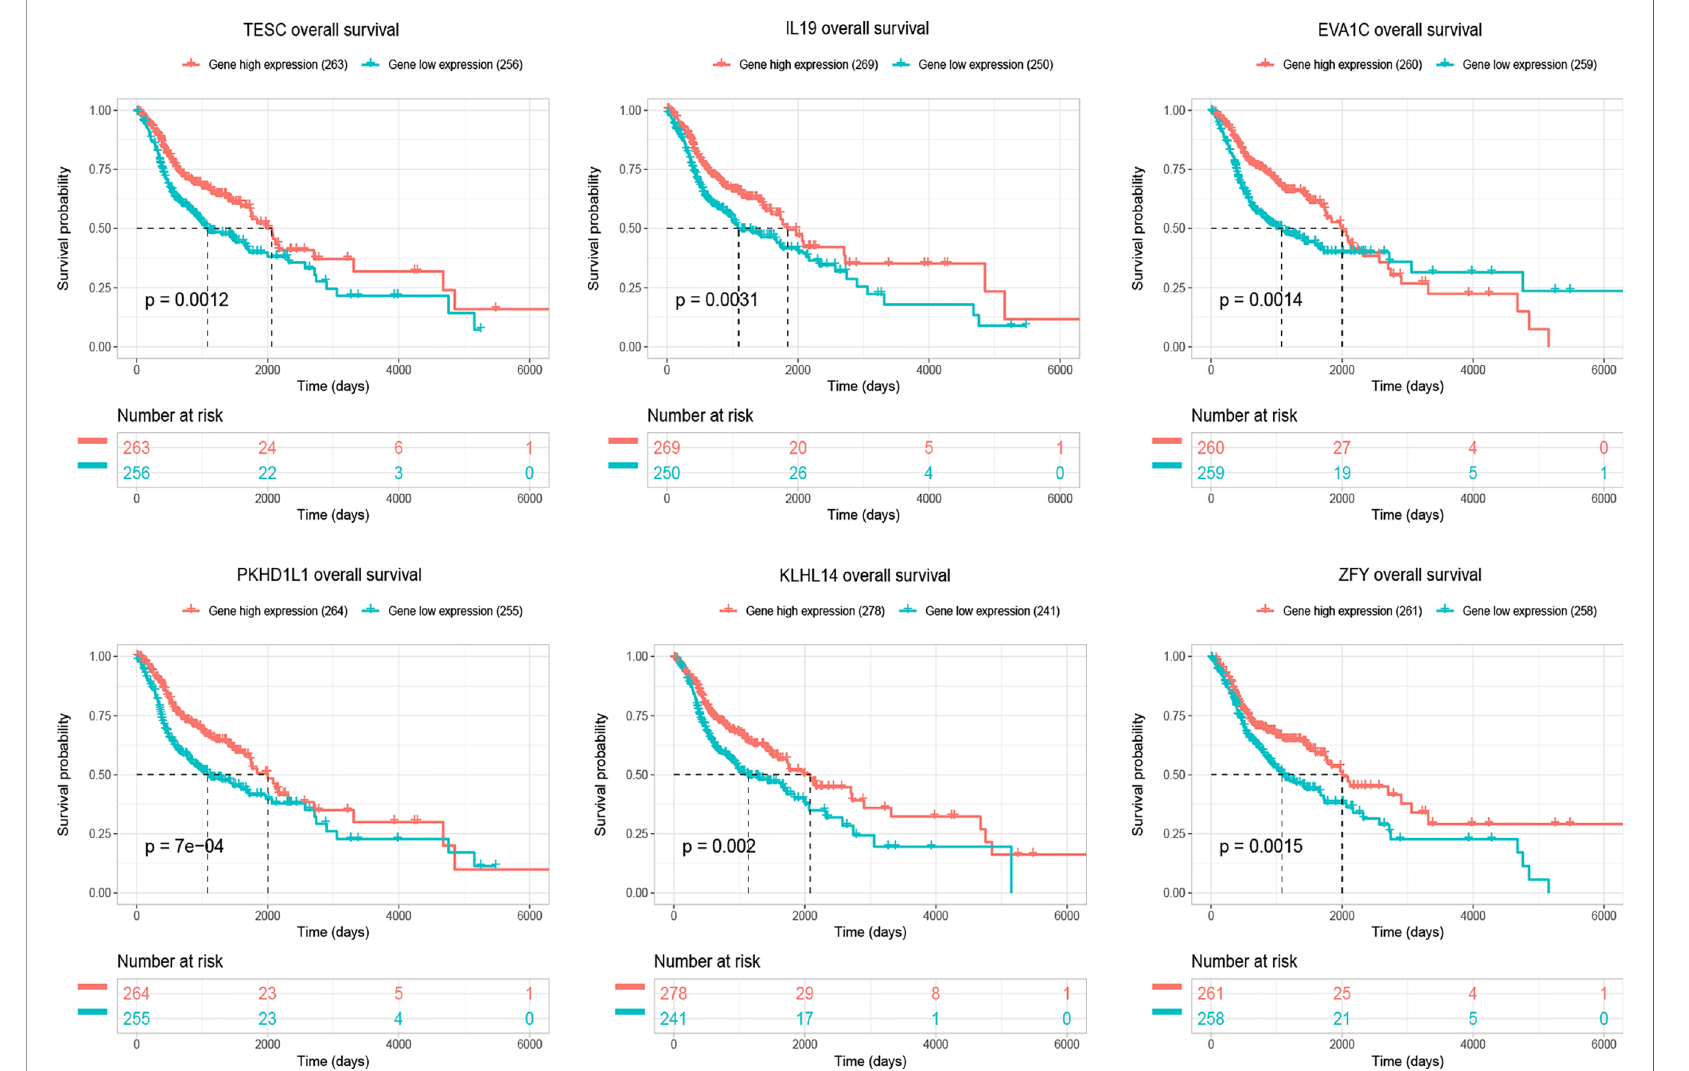
FIGURE 5 | The fi gure showed top six target mRNAs associated with OS of HNSC patients with the most signi fi cant P -values in a validation set of TCGA